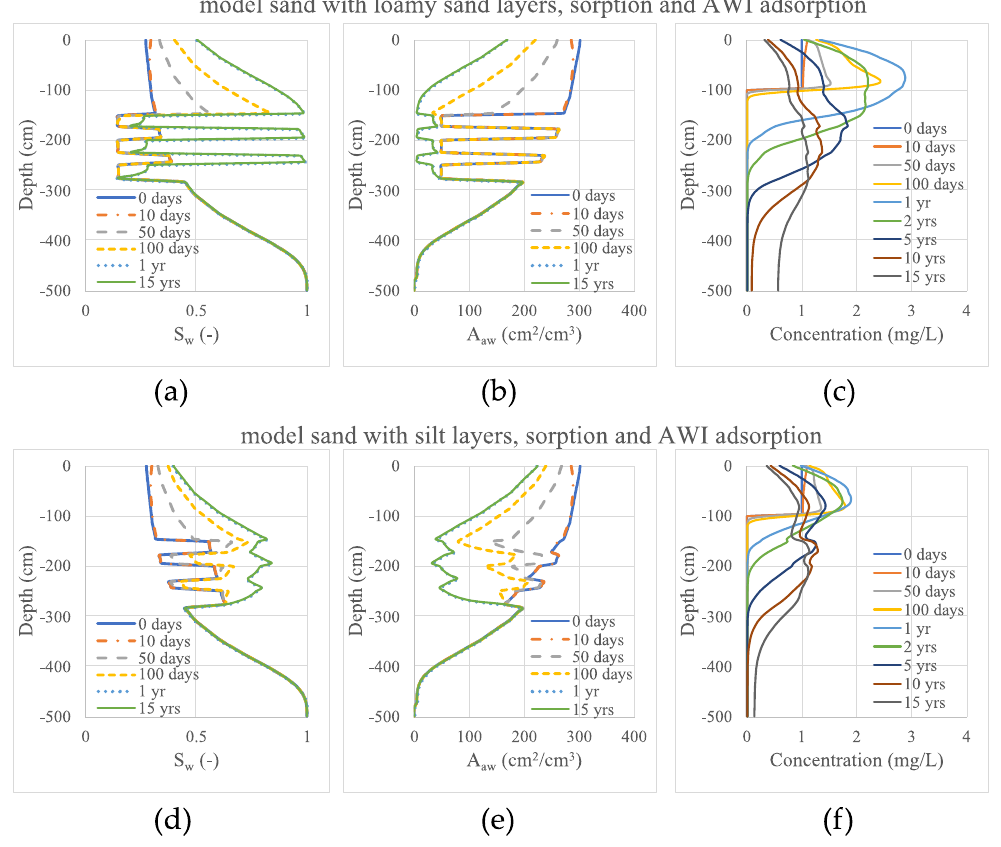
Figure 11. Simulated results of PFOS-unsaturated transport within a layered heterogeneous vadose zone (loamy sand and silt layers in a model sand vadose zone): ( a ) change in S w with depth for the loamy sand layered system; ( b ) change in A aw with depth for the loamy sand layered system; ( c ) PFOS transport within the loamy sand layered system; ( d ) change in S w with depth for the silt layered system; ( e ) change in A aw with depth for the silt layered system; ( f ) PFOS transport within the silt layered system.